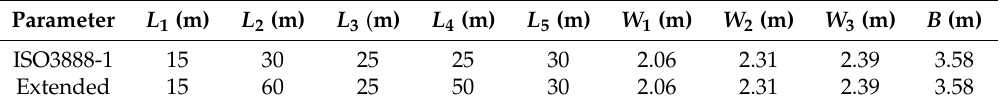
Figure 11. Double lane change manoeuvre. Table 3. Path